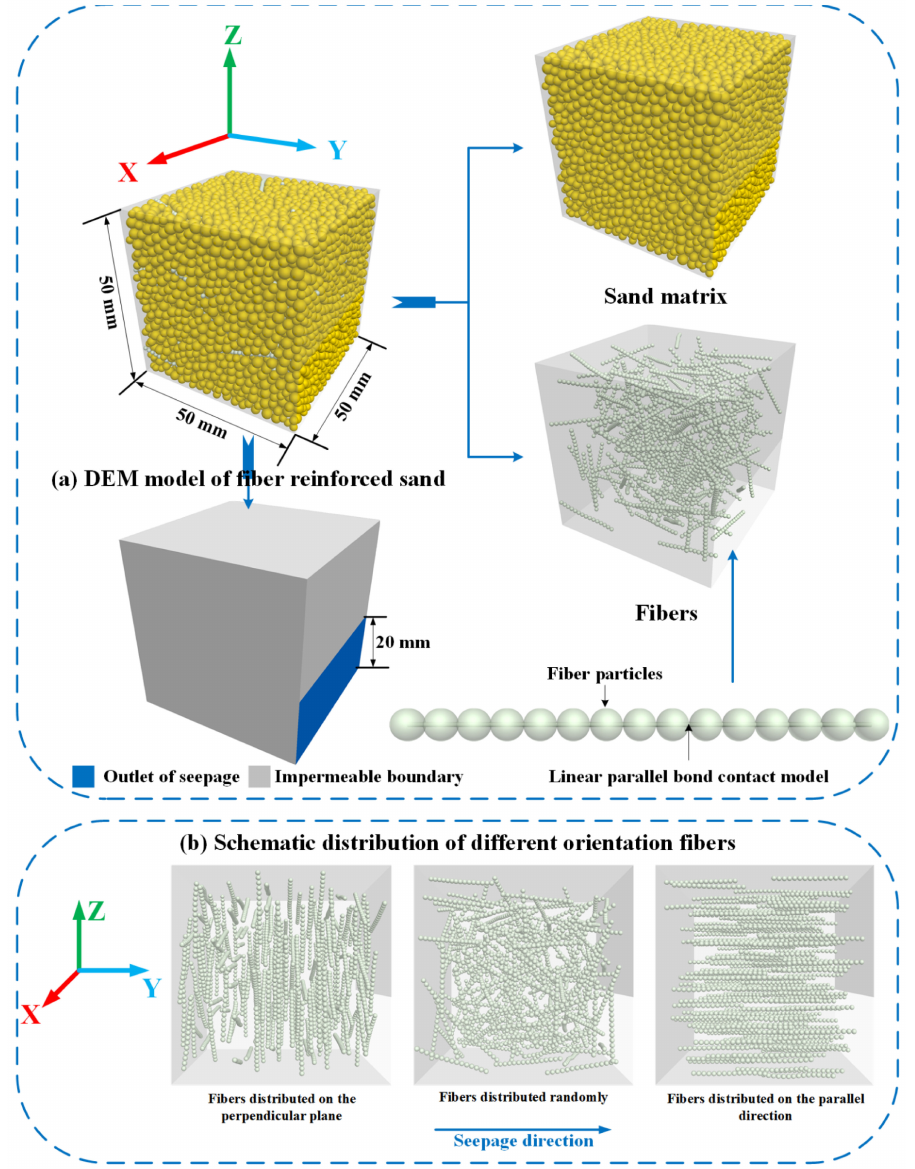
Figure 2. DEM-Darcy (two-way) coupling model of fiber-reinforced sand: ( a ) DEM model of fiber- reinforced sand; ( b ) three distribution states of